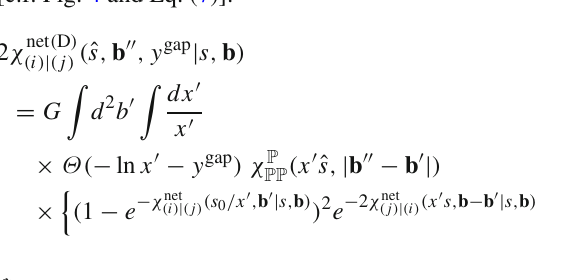
[c.f. Fig. 4 and Eq.